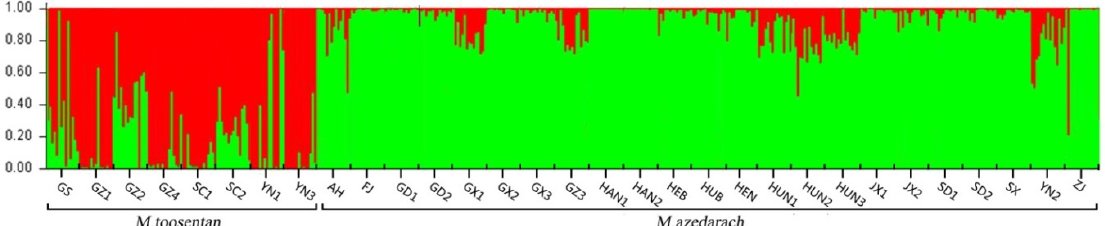
Figure 2. Relationship between K and Delta K . Delta K is an indicator of the optimal number of population groups. The number of groups with the maximum Delta K was optimal. Delta K was calculated according to Evanno et al . (2005) [36].